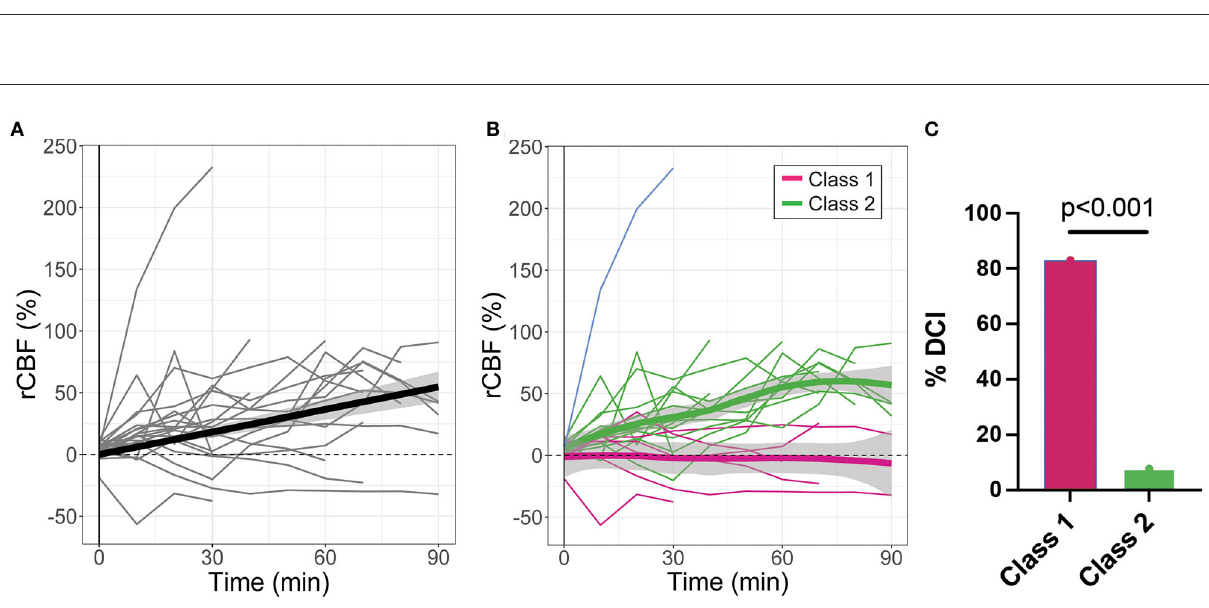
DCS monitoring sessions were discarded from the